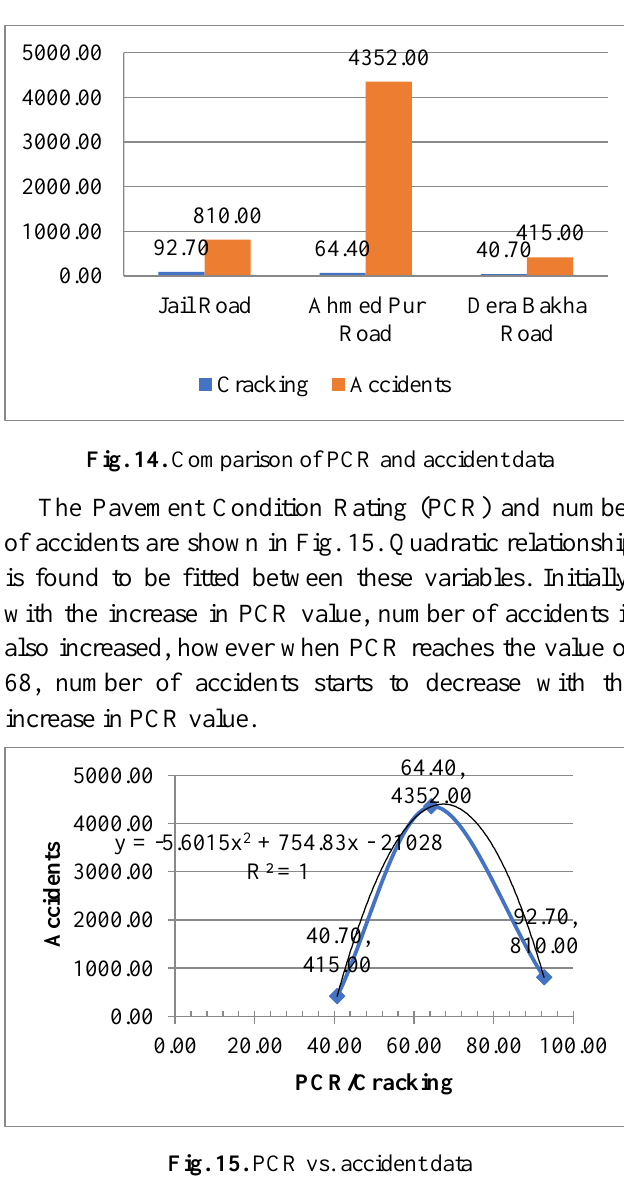
Fig. 16. Bar chart comparing PCR, accident data and